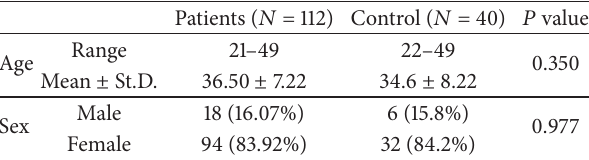
Table 1: Demographic data of patients and control group.